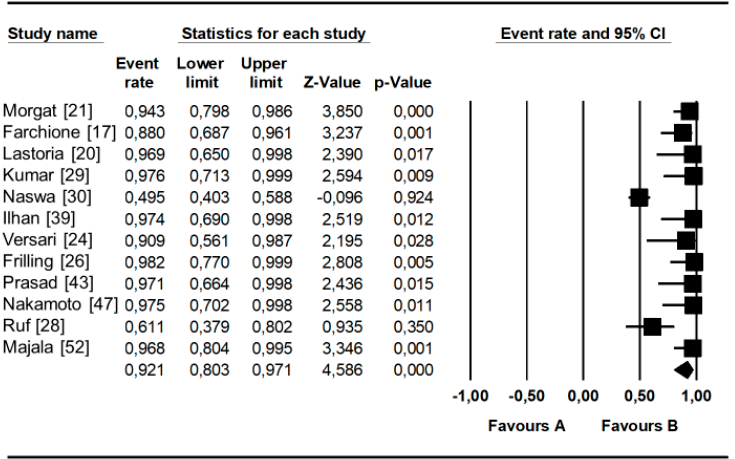
Figure 3. Detection rate at a per-lesion analysis. Plots of individual studies and pooled detection rate of SSR-PET/CT in patients with pNET on a per-lesion-based analysis, including 95%CI.